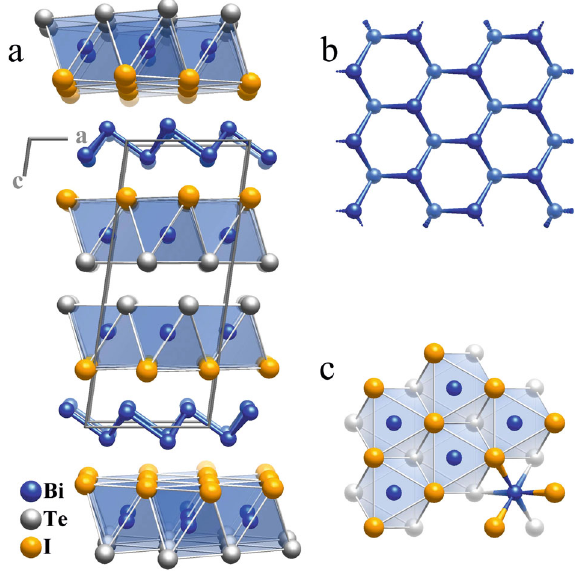
Fig. 1 Crystal structure of Bi 2 TeI. a Projection along the b -axis. b Top view on a [Bi 2 ] layer and c a [TeBiI] layer. Table 1. List of solvents and reaction conditions tested to exfoliate Bi 2 TeI.